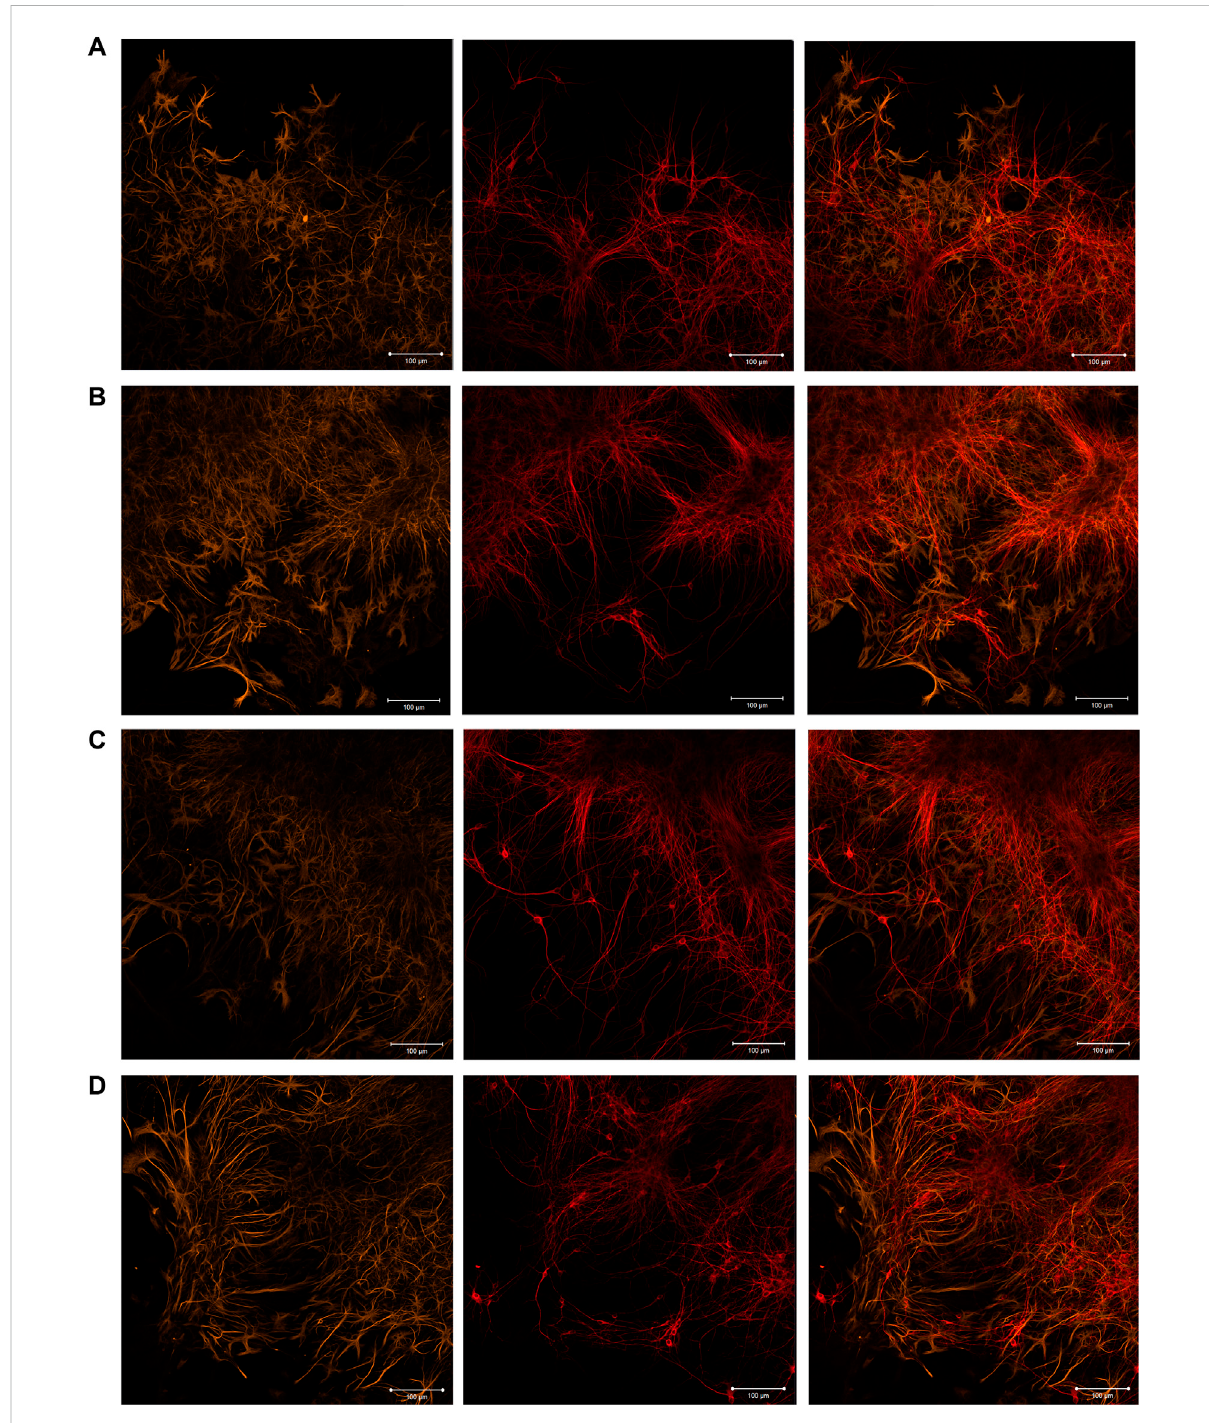
FIGURE 3 Immunocytochemical analysis of primary hippocampal cultures on day 7 of cultivation in vitro . Representative confocal images were obtained at the adjustment area of cultures relative to the scaffold. (A) Sham; (B) SC; (C) SC + BDNF; (D) SC + GDNF. Yellow: fl uorescence of a marker of cytoskeleton protein of differentiated astrocytes (GFAP) ( λ ex 488 nm; λ em 555 – 580 nm); Red: fl uorescence of a marker of neuronal protein (MAP2) ( λ ex 594 nm; λ em 650 – 665 nm); Merged: overlay of the fl uorescence channels. Scale bars, 100 μ